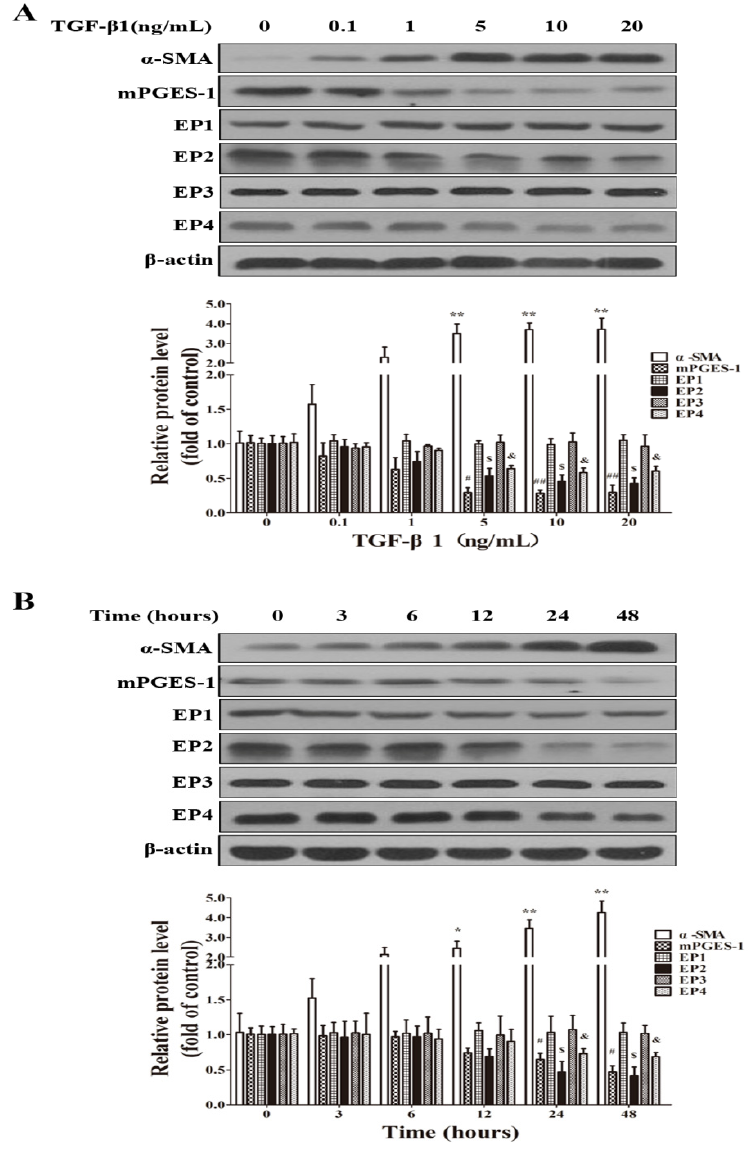
Figure 5. TGF- β 1 treatment reduced mPGES-1, EP2 and EP4 protein expression in MRC-5 cell lines. When the cells were grown to 80% confluence, they were starved for 24 h and treated with various concentrations of TGF- β 1 (0, 0.1, 1, 5, 10 and 20 ng/mL) for 24 h or treated with 5 ng/mL TGF- β 1 for various time length (0, 3, 6, 12, 24 and 48 h). TGF- β 1 dose-dependently increased the protein levels of α -SMA, and reduced that of mPGES-1, EP2 and EP4, and the representative western blot images and scanning densitometry of protein expression were shown in ( A ); ( B ) Time course of TGF- β 1 on the expression levels of α -SMA, mPGES-1, EP1, EP2, EP3 and EP4 in MRC-5 cells. Results are expressed as means ± SEM ( n = 3) ( * p < 0.05, ** p < 0.01 versus TGF- β 1 absence or TGF- β 1 treated at 0 time point group in α -SMA expression level; # p < 0.05, ## p < 0.01 versus TGF- β 1 absence or TGF- β 1 treated at 0 time point group in mPGES-1 expression level; $ p < 0.05 versus TGF- β 1 absence or TGF- β 1 treated at 0 time point group in EP2 expression level; & p < 0.05 versus TGF- β 1 absence or TGF- β 1 treated at 0 time point group in EP4 expression